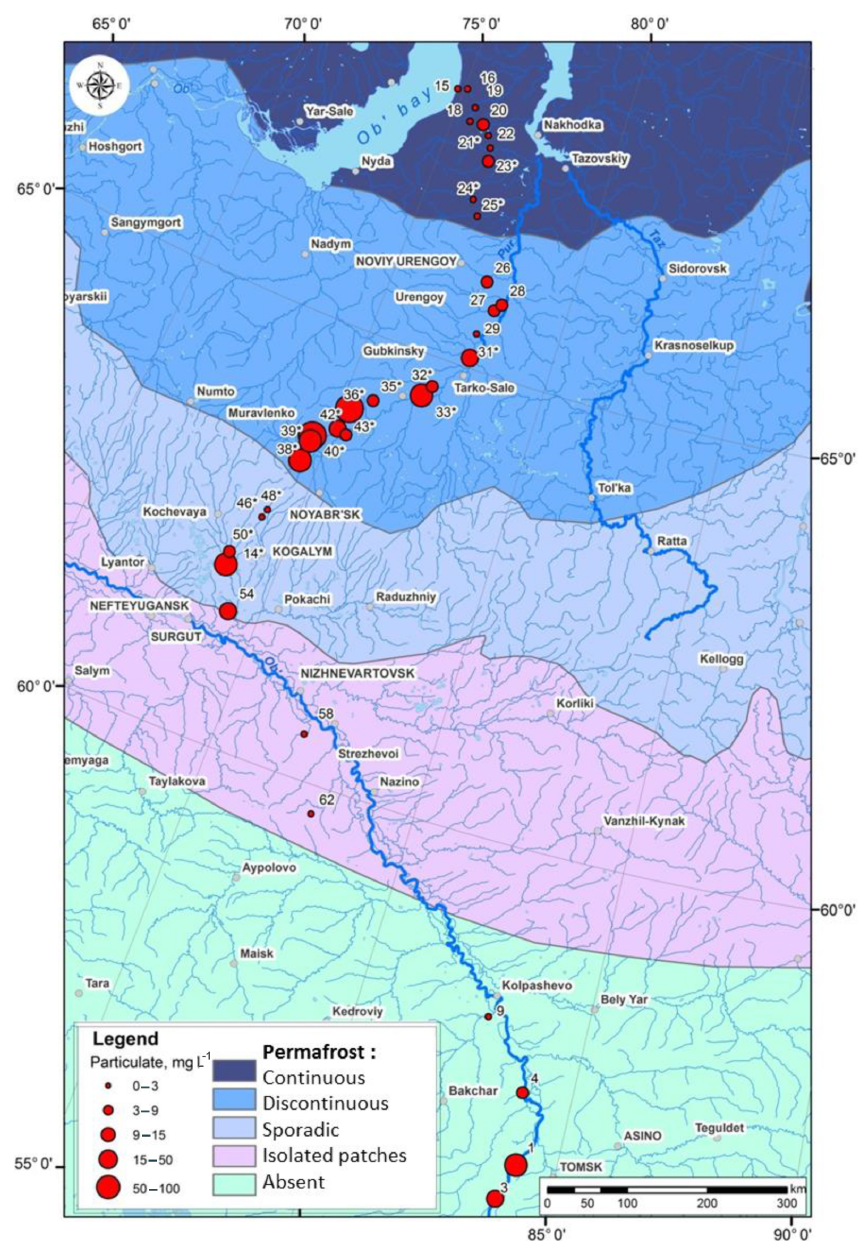
Figure 1. Map of the study site with permafrost zone boundaries. The size of the sampling points reflects the concentration of particulate fraction (mgL − 1 snowwater ) . The boundaries of permafrost zones are from Brown et al.